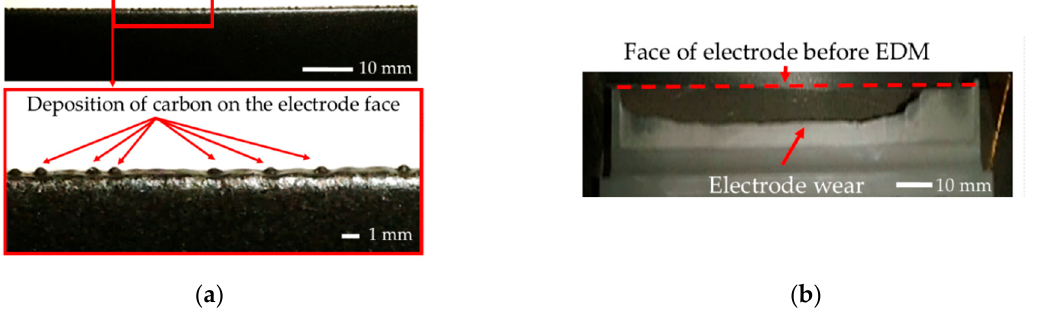
Figure 7. Graphite electrode: ( a ) face of tool electrode after two minutes of work; ( b ) uneven electrode wear after processing slot.